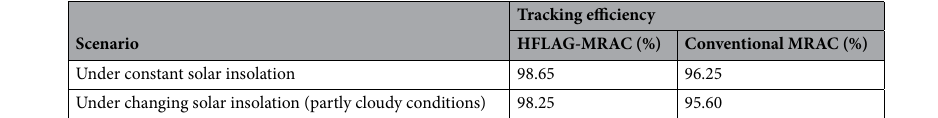
Table 7. Tracking efficiency under different environmental scenarios.